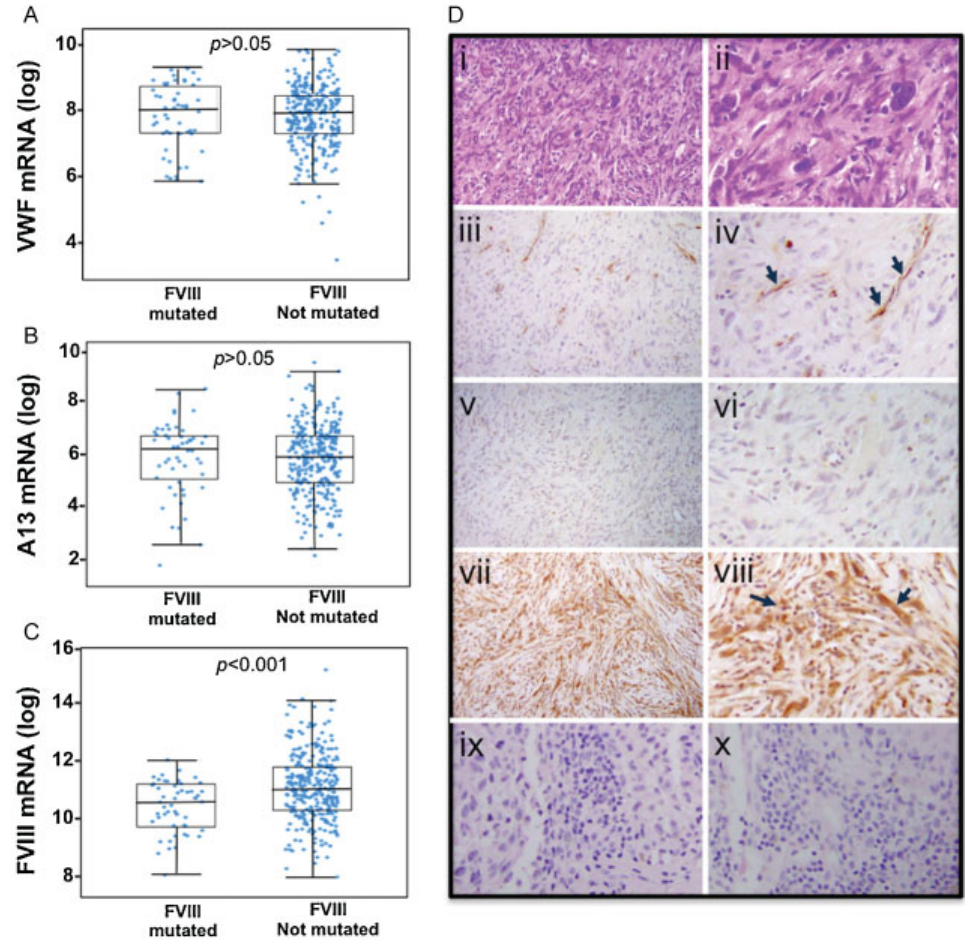
Fig. 5 Associationbetweenmutationsin FVIII andexpressionof VWF , FVIII ,and ADAMTS13 mRNAinpatientswithcutaneousmelanoma.ThelevelsofmRNA expression(mean (cid:2) 95%con fi dentialinterval)for VWF ( A ), FVIII ( B ),and ADAMTS13 ( C )inpatientswithorwithout FVIII mutations.( D ).Hematoxylinandeosin staining(iandii)andimmunohistochemistry withrabbitanti-VWFIgG(iiiandiv), sheepanti-FVIIIIgG(vandvi), andrabbitanti-ADAMTS13IgG(viiandviii), followed by streptavidin-peroxidase conjugated anti-rabbit IgG or anti-sheep IgG or secondary antibody only (ix and